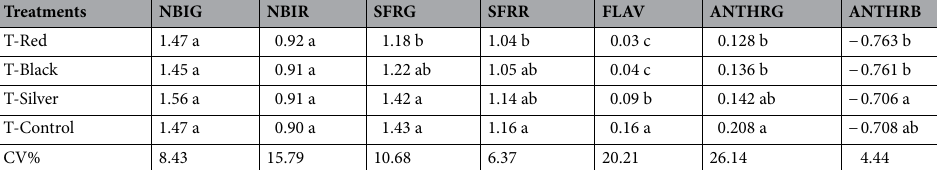
Table 5. Mean values of nitrogen balance (NBIG and NBIR), chlorophyll (SFRG and SFRR), flavonoids (FLAV) and purple lettuce anthocyanins (ANTHRG and ANTHRB) indices grown in different photo-selective screens and in full sun. Means followed by the same letter do not differ from each other at the 5% probability level (p < 0.05) by the Tukey test.